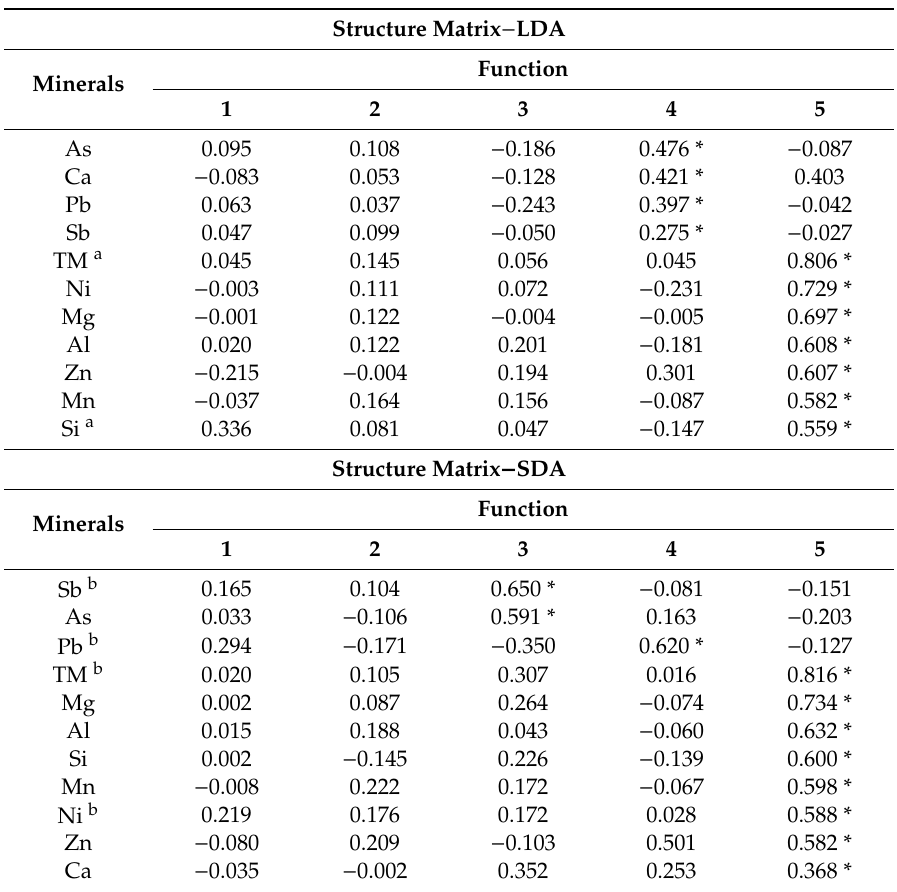
Table 2. Contribution of minerals to the discriminant function matrix during LDA and